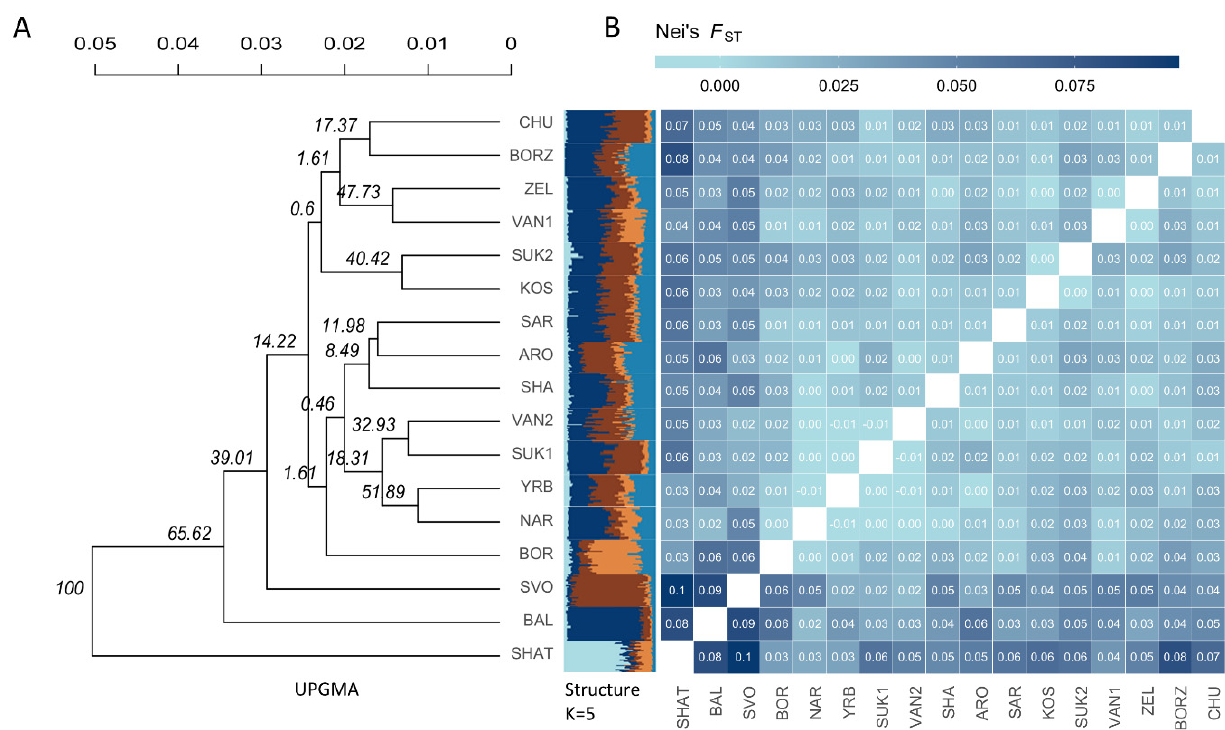
ropean part of Russia (SHAT), as well as the easternmost (SVO) and southernmost (BAL)